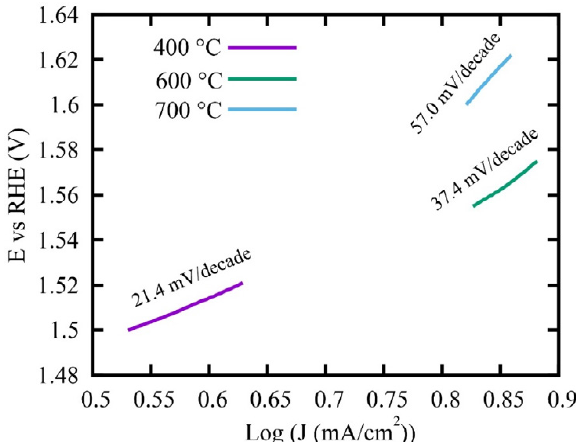
Fig. 4. The Tafel slope values of the electrodes synthesized at different